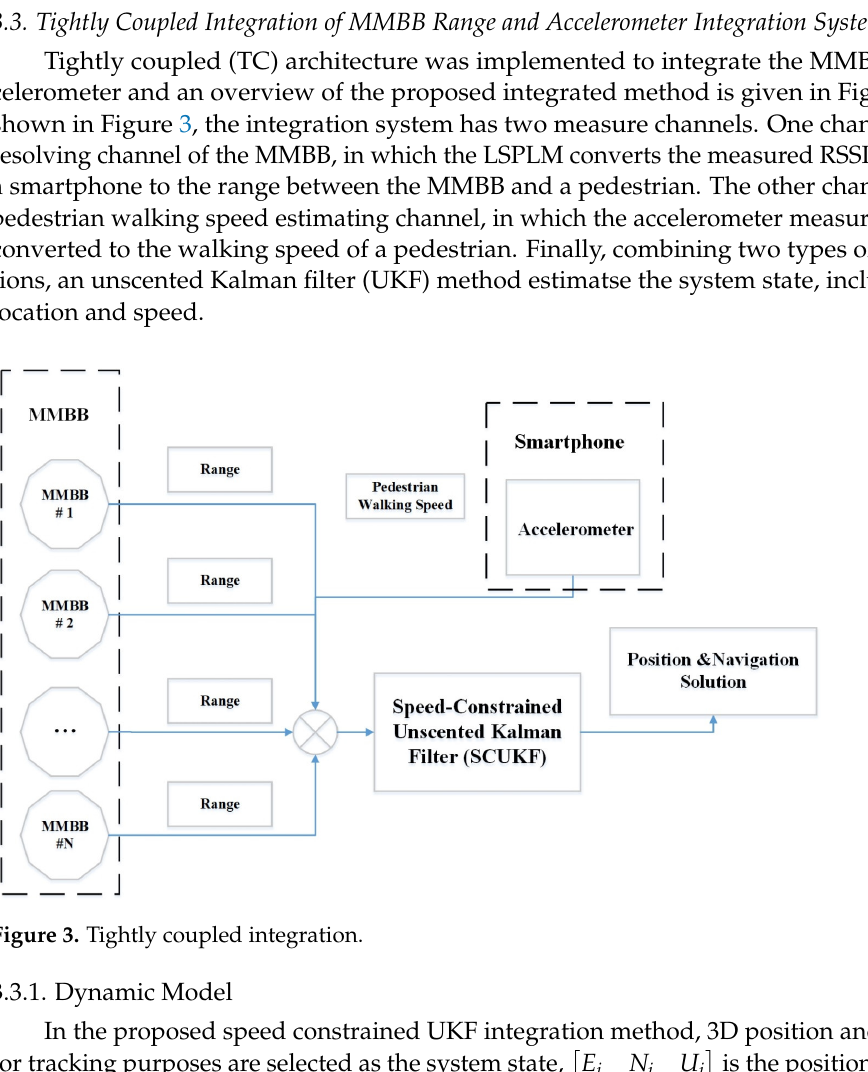
Figure 2. ( left side ) The cyclic pattern of triaxial and total accelerations during a walking process; ( right side ) comparison between the total accelerations and total accelerations after filtering.